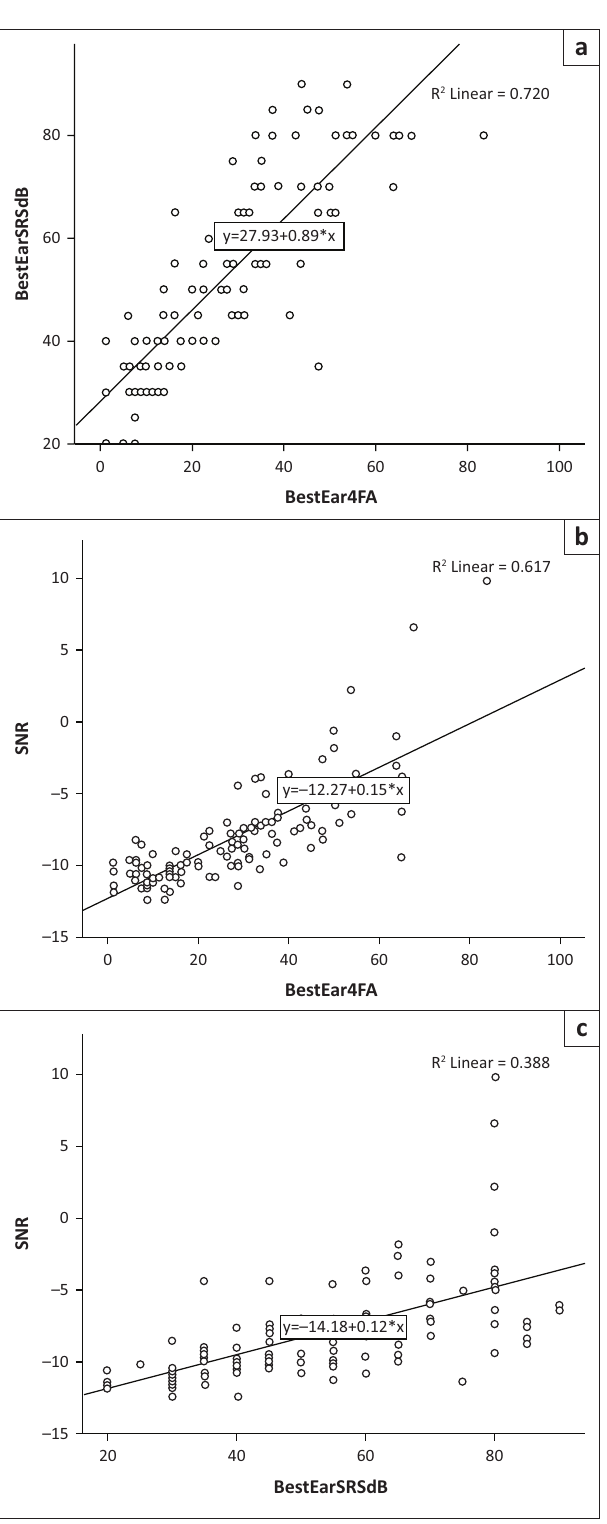
FIGURE 1: (a) Scatterplot indicating the correlation between the best ear 4 frequency pure-tone average and maximum speech recognition monaural performance scores; (b) Scatterplot indicating the correlation between the best ear 4 frequency pure-tone average and digits-in-noise signal-to-noise ratio; (c) Scatterplot indicating the correlation between the best ear maximum speech recognition monaural performance scores and digits-in-noise signal-to-noise ratio.